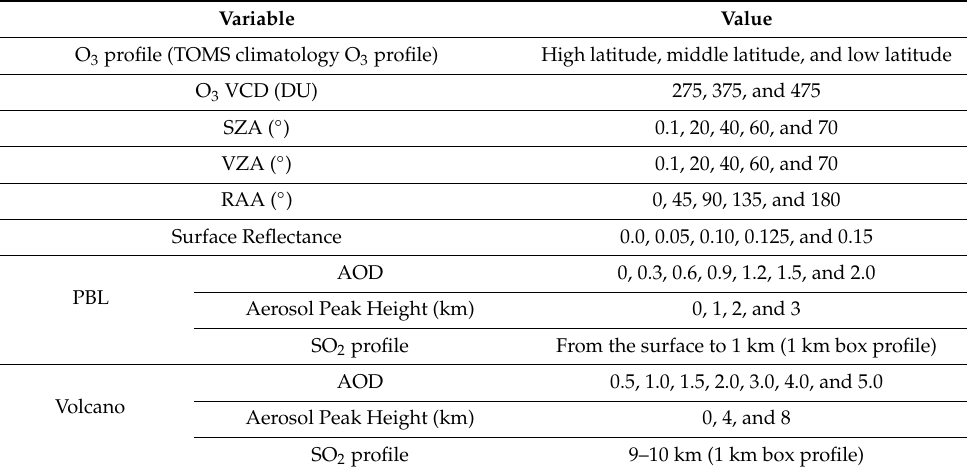
Table 1. Variables used to calculate the SO 2